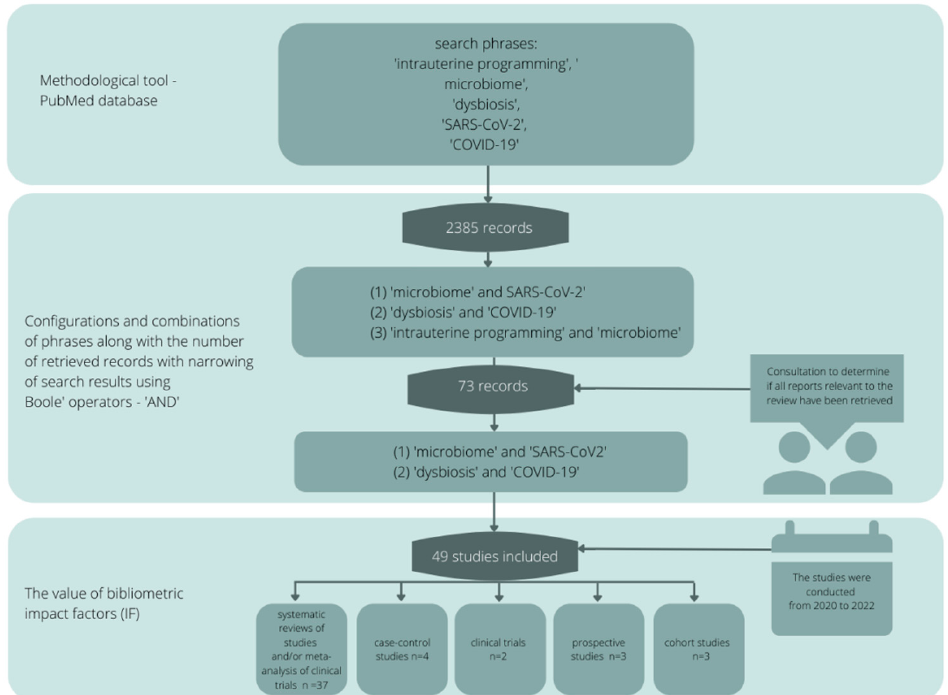
Figure 3. Publication search